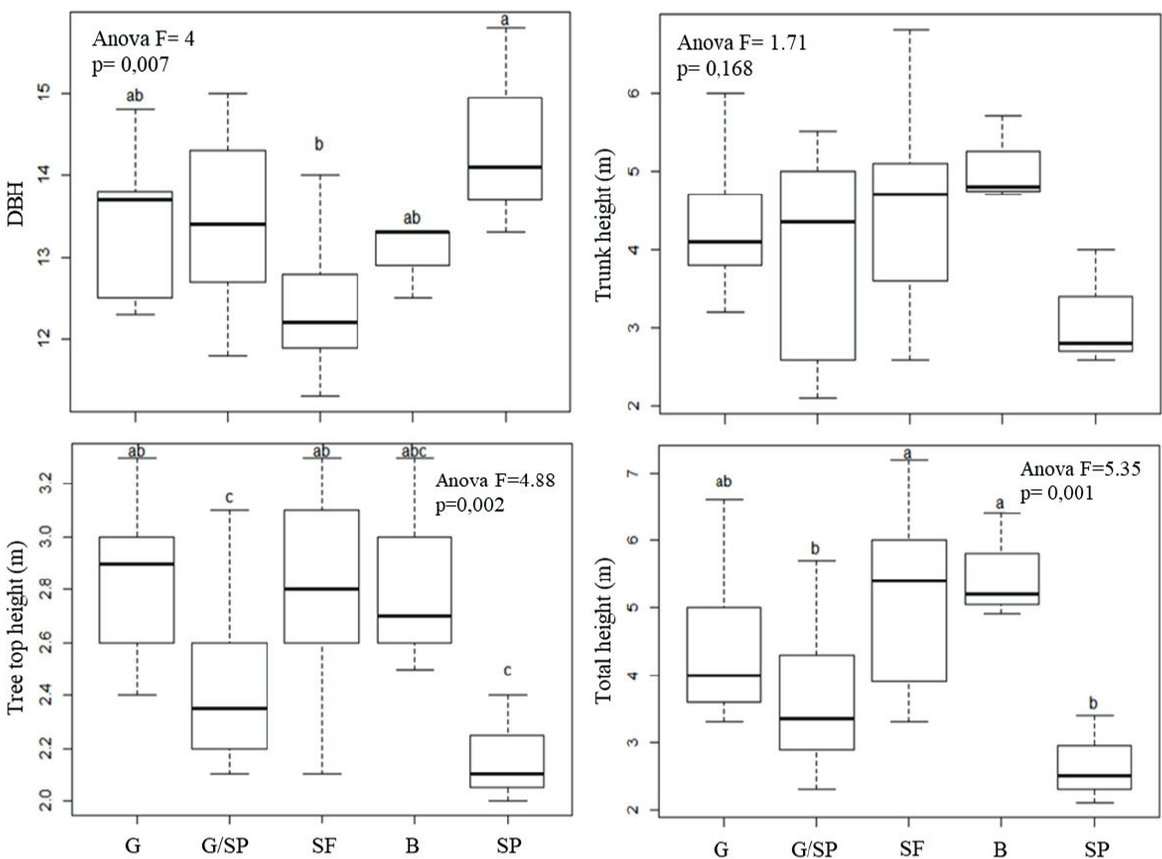
Figure 4. ANOVA (F) of biotic variables compared between the different physiognomies. p indicates the level of signifi cance and different letters indicate signifi cant differences between physiognomies according to Tukey’s post-hoc test (p <